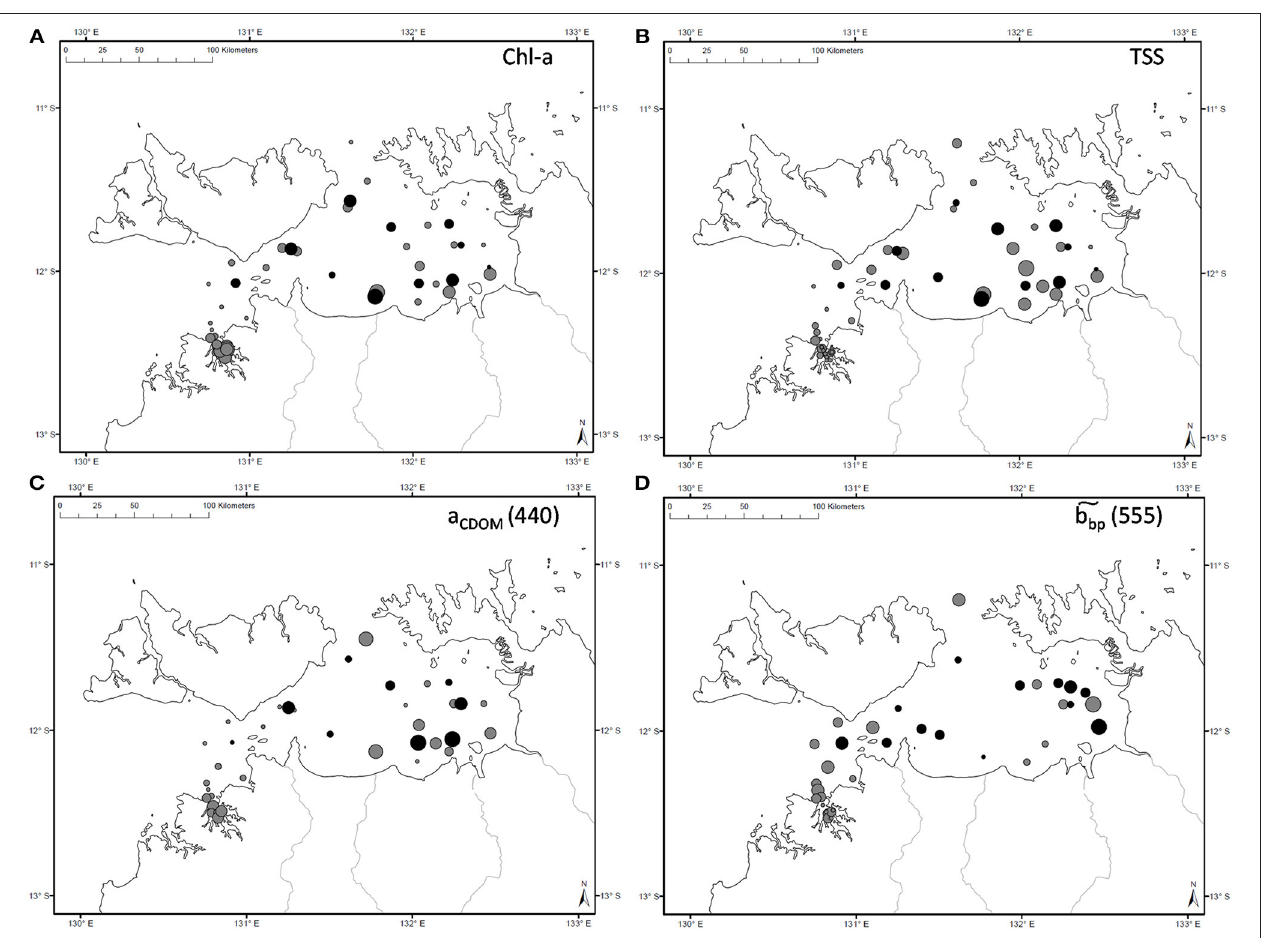
FIGURE 2 | Spatial distribution of measured (A) Chl-a, (B) TSS, (C) a CDOM (440), and (D) f b bp555 during the dry (gray) and wet (black) seasons. Symbol sizes are representative of the concentration range sampled during a specific season.